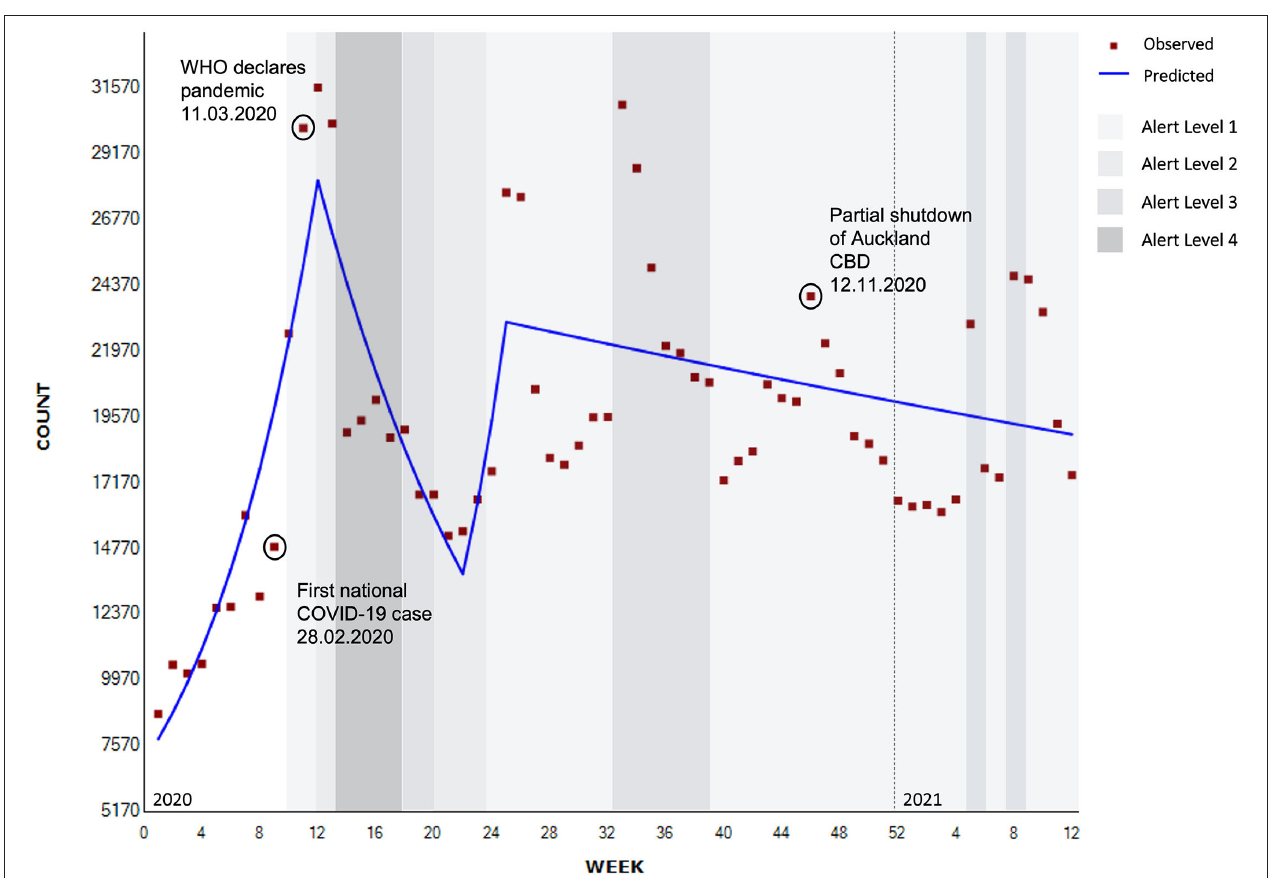
FIGURE 2 | Segmented regression analysis of total contacts to national helplines (weekly) ( N = 1,244,293).